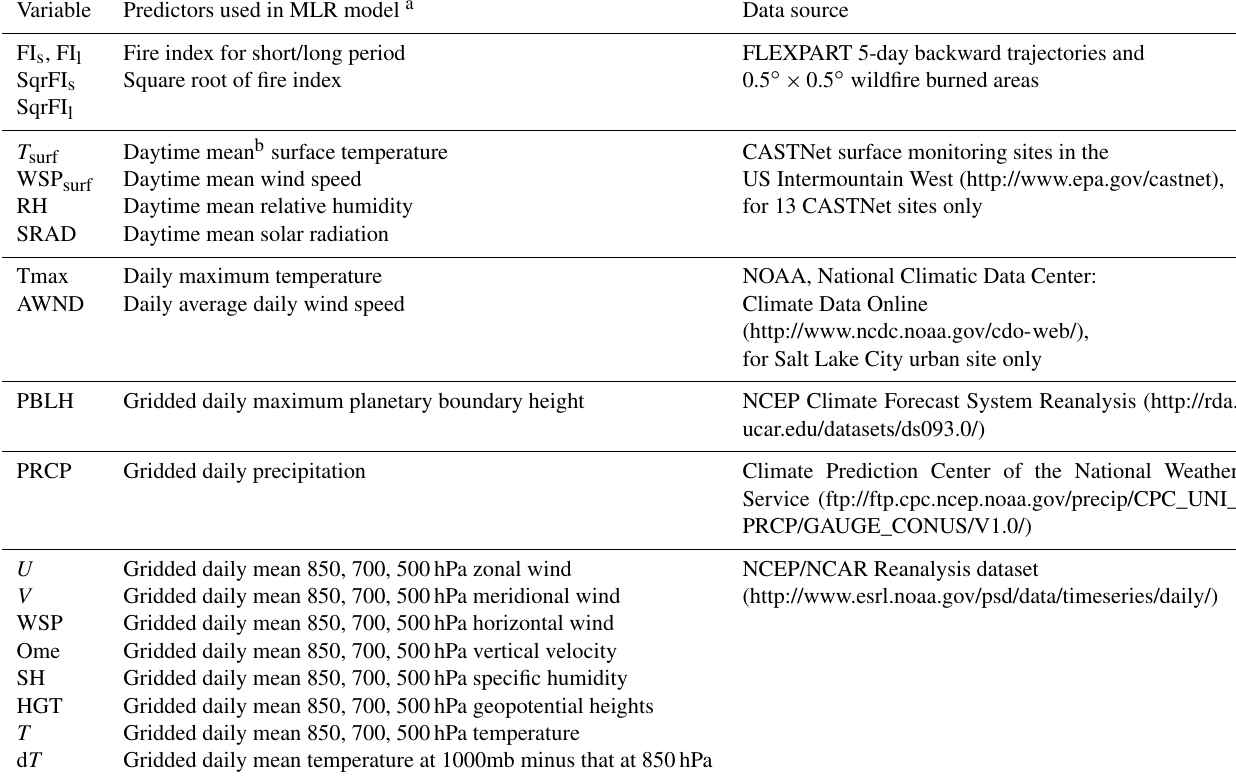
Table 1. Variables used in the MLR models.